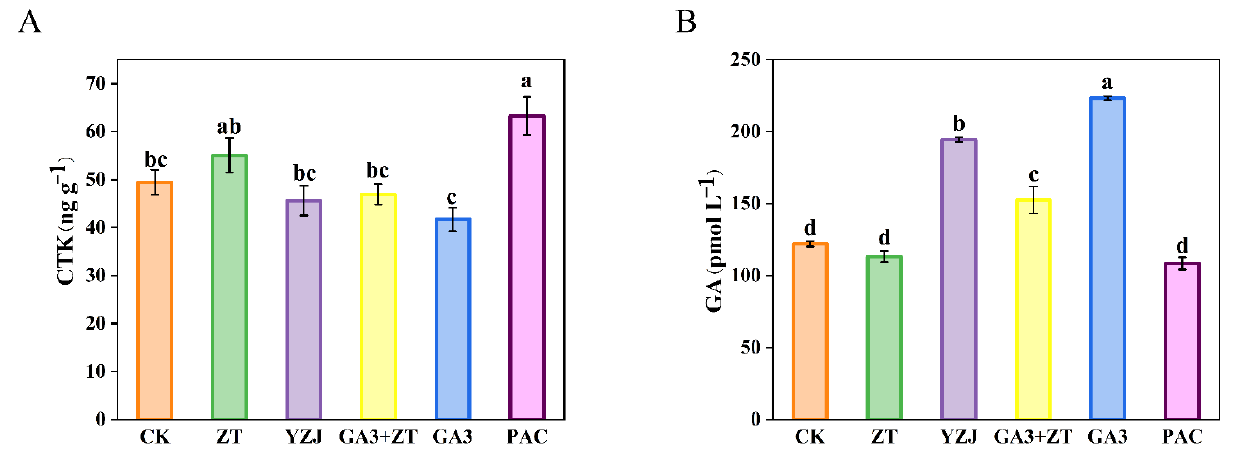
Figure 3. Hormone contents in shoot apices of flowering Chinese cabbage under control and different hormone treatments. ( A ) cytokinin (CTK). ( B ) gibberellin (GA). Statistically significant differences in mean values at different sampling points are indicated by different letters (Duncan’s test, p < 0.05). Bars are SE ( n = 4).